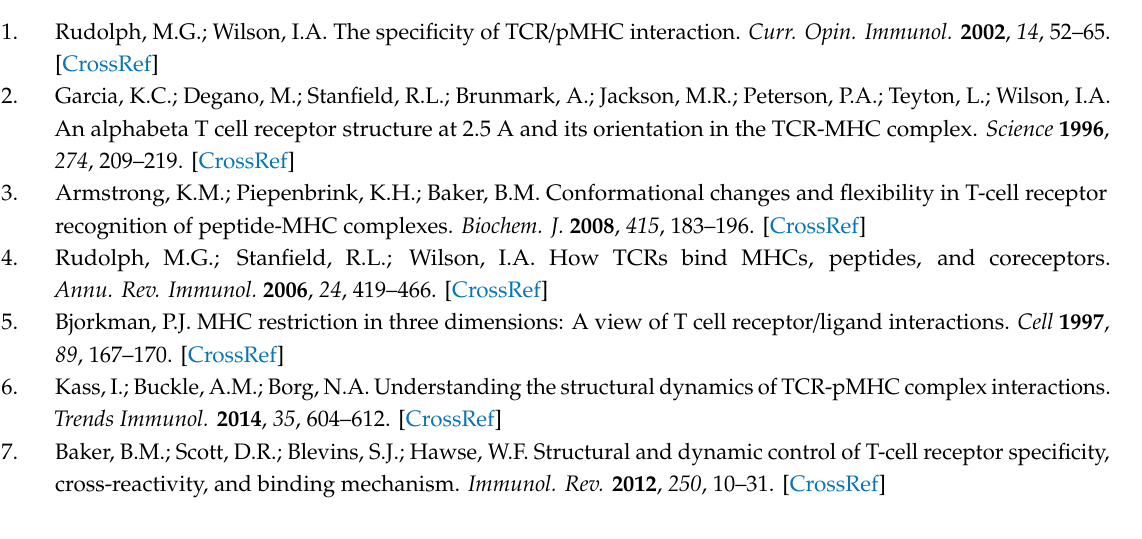
Figure S1: Cartoon representations of CDR3 α loops (Ile91, Leu92, Pro93, Leu94, Ala95, Gly96, Gly97, Thr98, Ser99, Tyr100, Gly102, Lys103, Leu104, Thr105) in free (A) and bound (B) states. Residues Ala95 (blue), Gly96 (grey), and Gly97 (grey) exhibit a structural change from a 3 10 -helix (free, panel A) to a coil (bound, panel B). VMD [22] was used to identify structural changes and to produce the figures. Video S1: Movie of one 144 ns run of the TCR-pMHC complex started from the crystal structure